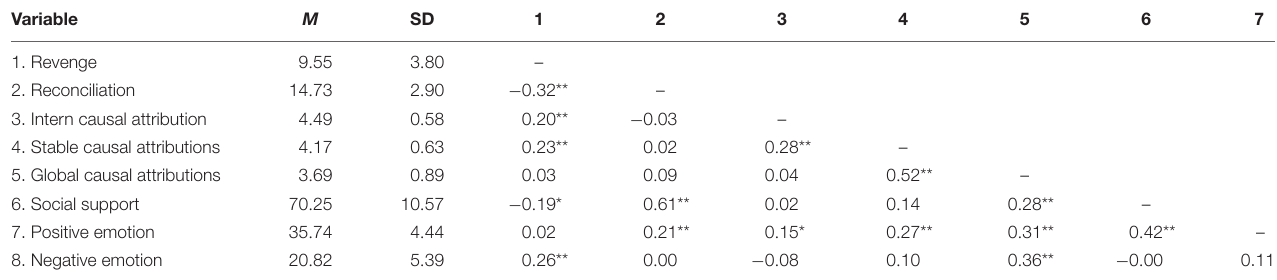
TABLE 1 | Descriptive statistics and correlation test between the scale scores.